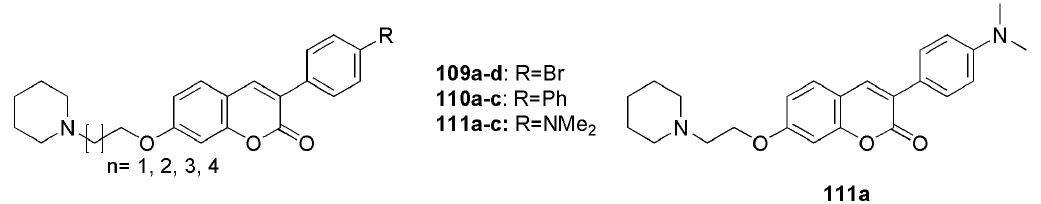
Figure 42. Chemical structures of alkylamino coumarins 109a–d , 110a-c and 111a–c.